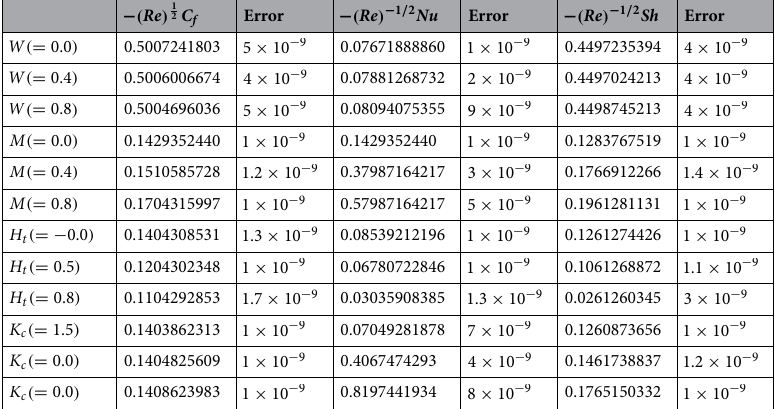
Table 5. Numerical analysis of Nusselt number, skin friction coefficients, and Sherwood number with error analysis against variation in W , M , H t and K c